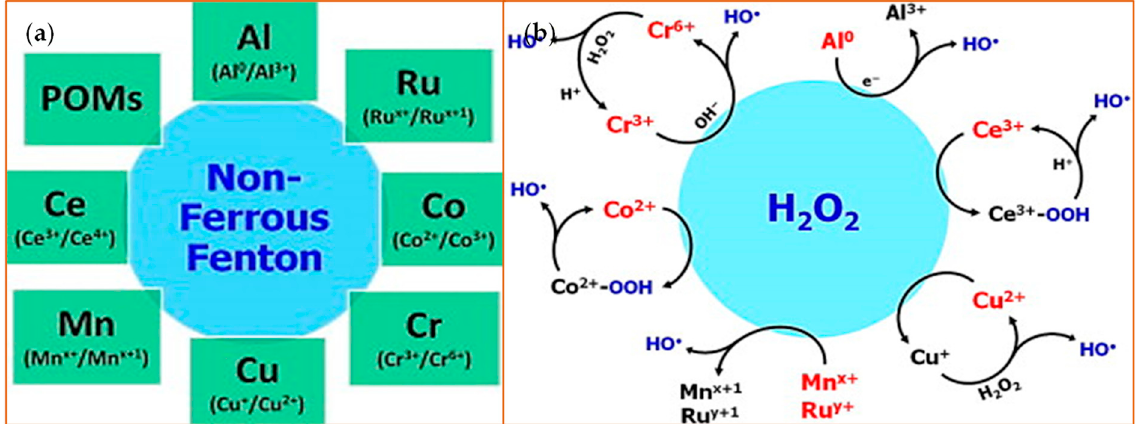
Figure 3. Non ‐ ferrous Fenton ions and their reaction with hydrogen peroxide. ( a ) A schematic is shown that highlights non ‐ Ferrous Fenton ions with the oxidation states that catalyze the substrates [47] . Polyoxometalates (POMs) are metal oxyanion clusters; ( b ) This schematic depicts an overview of the redox reactions between H 2 O 2 and various non ‐ ferrous Fenton catalysts. The species highlighted in red or blue indicate the active Fenton catalyst and the product, respectively. Reprinted with permission from ref. [47] . Copyright 2014 Elsevier.